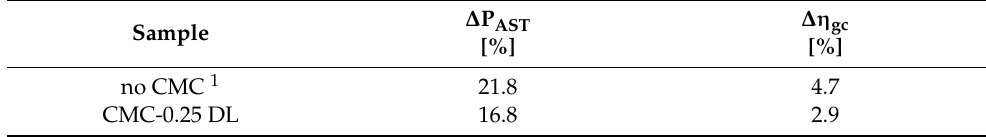
Figure 7. Polarization and power density curves obtained with the CMC-0.25 DL samples upon constant current tests and AST, compared with the fresh sample. Table 3. Variation of the maximum output power density and global cell efficiency upon ASTs.